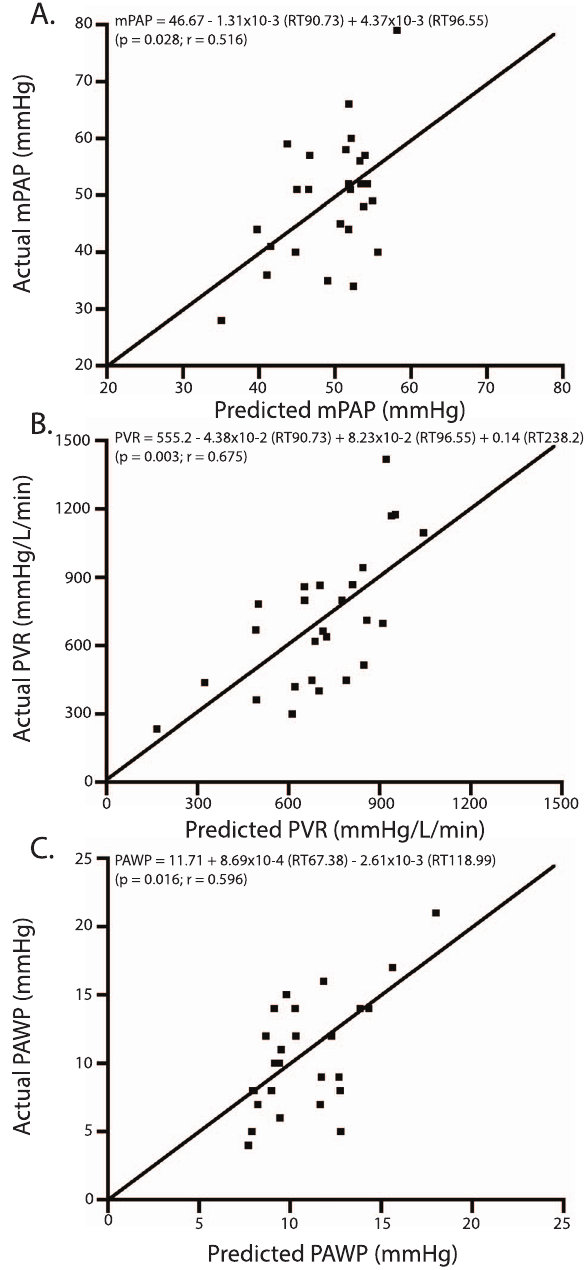
Figure 3. Plots of step-wise linear regression analysis of actual vs. predicted values for mPAP, PVR, and PAWP. There were significant associations between mPAP and peak heights at retention times of 90.733 and 96.547 minutes (A); PVR and peak heights at retention times of 90.733, 96.547 and 238.247 minutes (B); PAWP and peak heights at retention times of 67.380 and 118.995 minutes (C). outcomes of the AR/PLSR, correlation and regression analyses. This finding indicates that differences in BMI do not affect the unique characteristics of the chromatograms and individual peaks identified in our study groups using GC/MS.